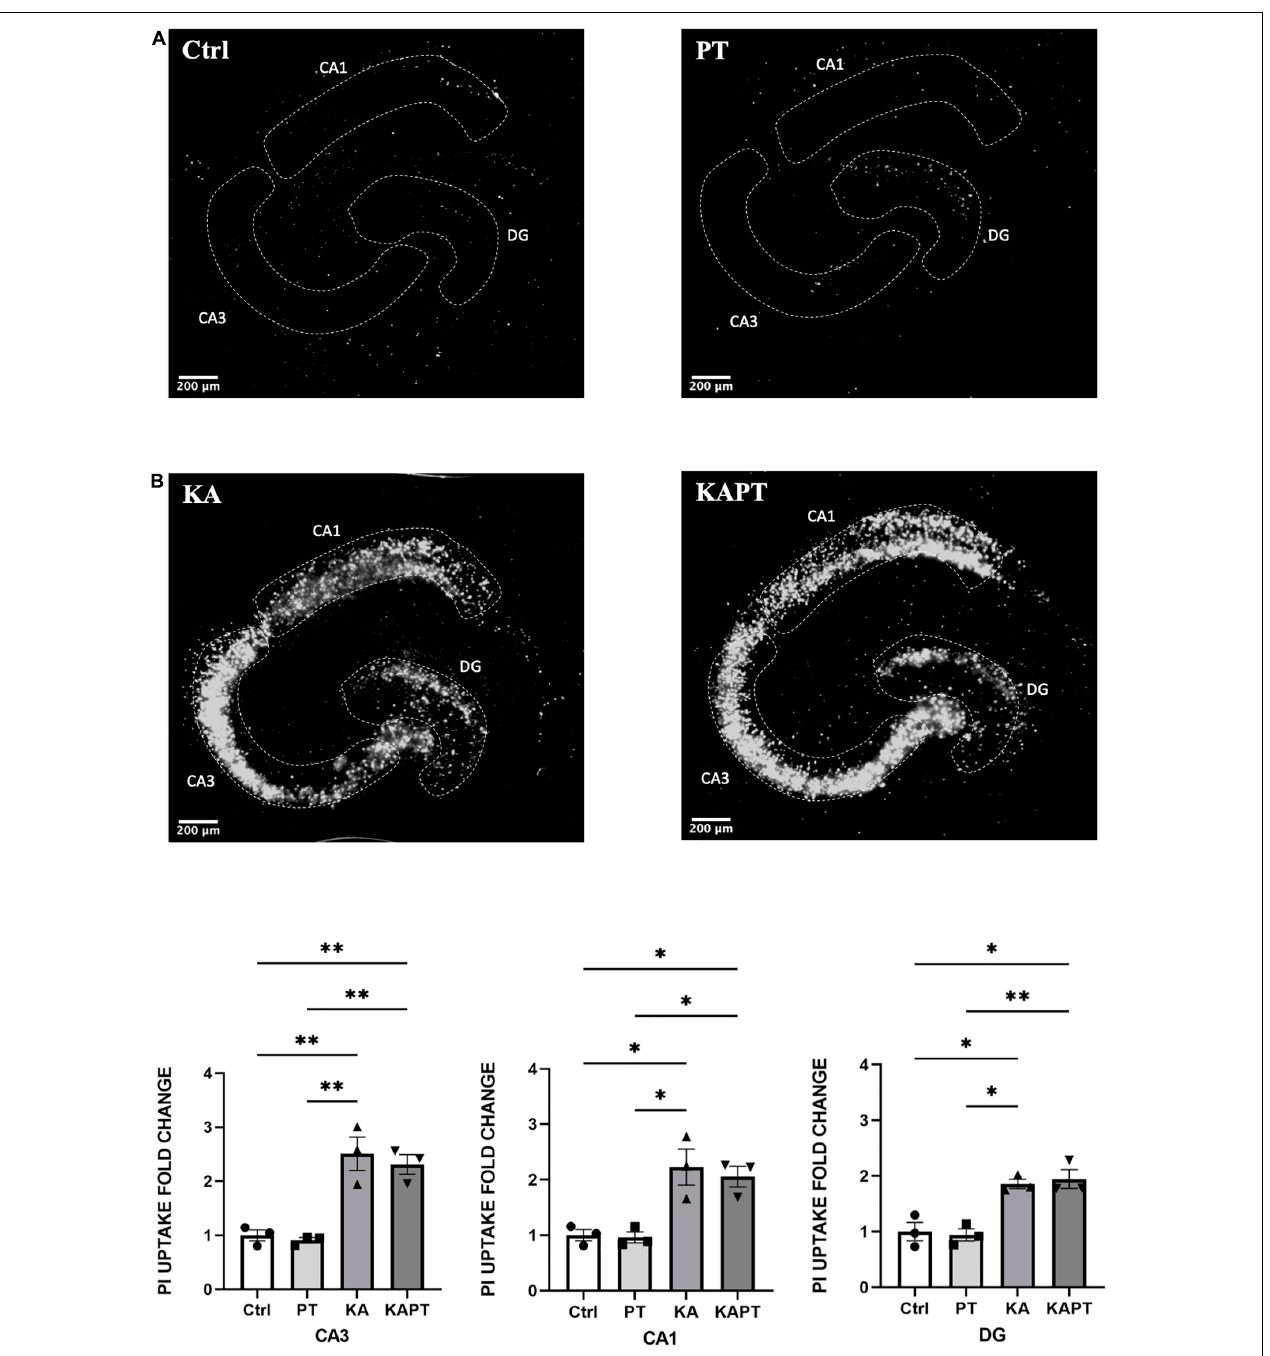
FIGURE 2 | Platinum nanoparticles (PtNPs) do not impact cell viability in normal and pathological conditions after 24 h of contact. (A) Representative propidium iodide (PI) staining of dead cells in organotypic hippocampal slices under control conditions (CTRL; untreated slices), PtNPs (PT), kainic acid treatment (KA), and KA treatment + PtNPs (KAPT). (B) Quantitative analysis of PI uptake in CA3, CA1, and dentate gyrus (DG) in normal and pathological conditions. Data are expressed as integrated density fold change from the basal value of control slices and presented as mean ± standard error of the mean (SEM) ( n = 3 independent experiments; 4–6 slices analyzed per group/experiment). Tukey’s test after one–way analysis of variance (ANOVA) was used for statistical analysis. ∗ p < 0.05; ∗∗ p <